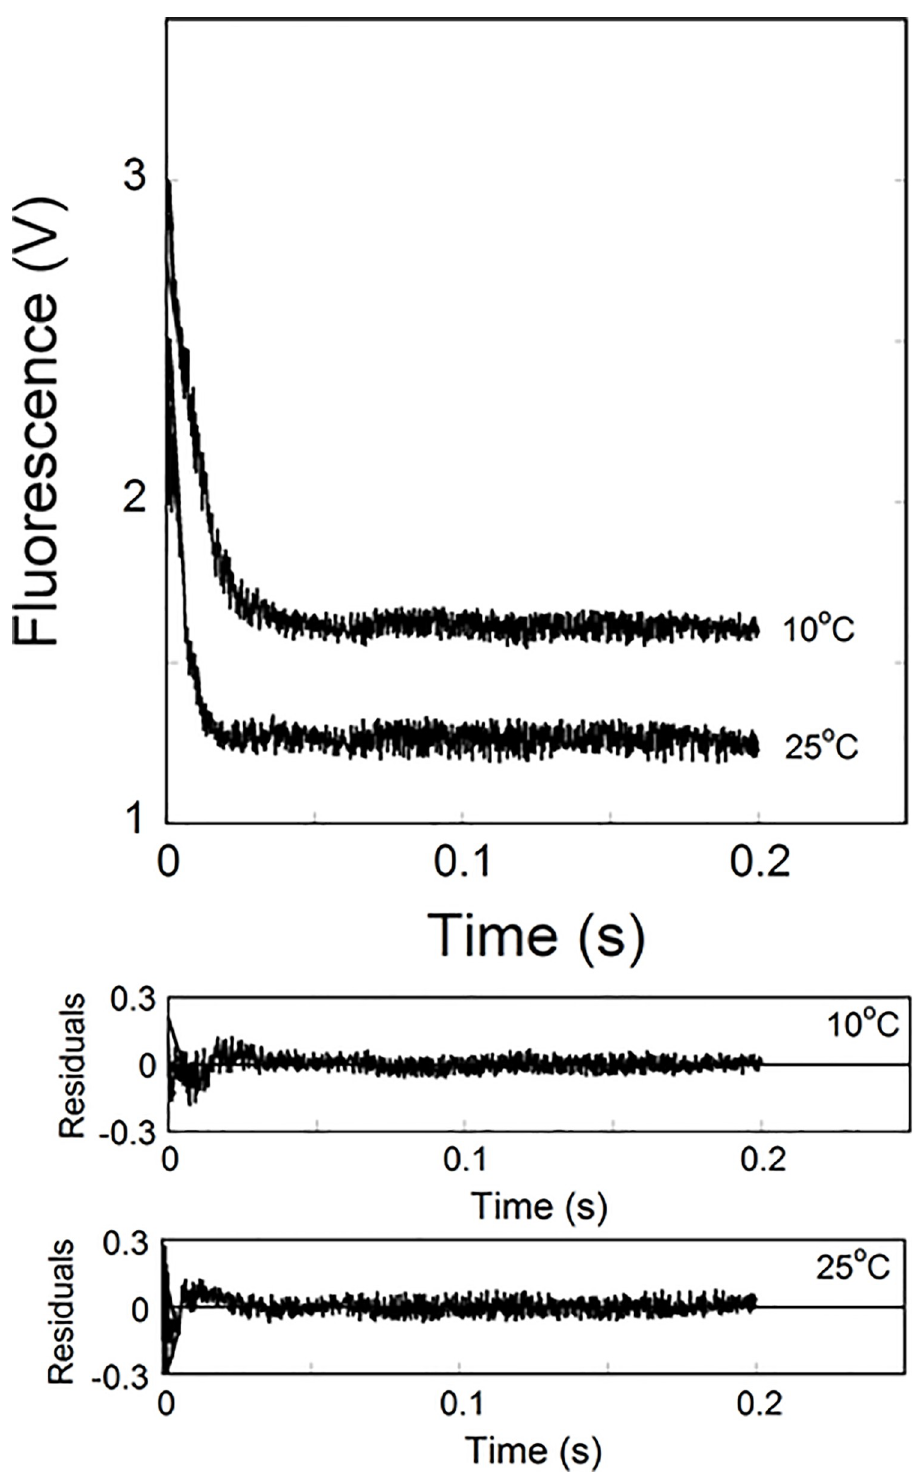
Fig 3. Temperature dependence Kinetic measurements of eIFiso4Ep � VPg binding. Kinetic traces of eIFiso4Ep (0.1 μ M, final) association with VPg (1.0 μ M, final) at temperature 283 K and 298 K. The curve ( solid line ) represents the fitted line drawn through the data points was fit by assuming a single exponential process. Residuals for the fits are shown in the lower panels .